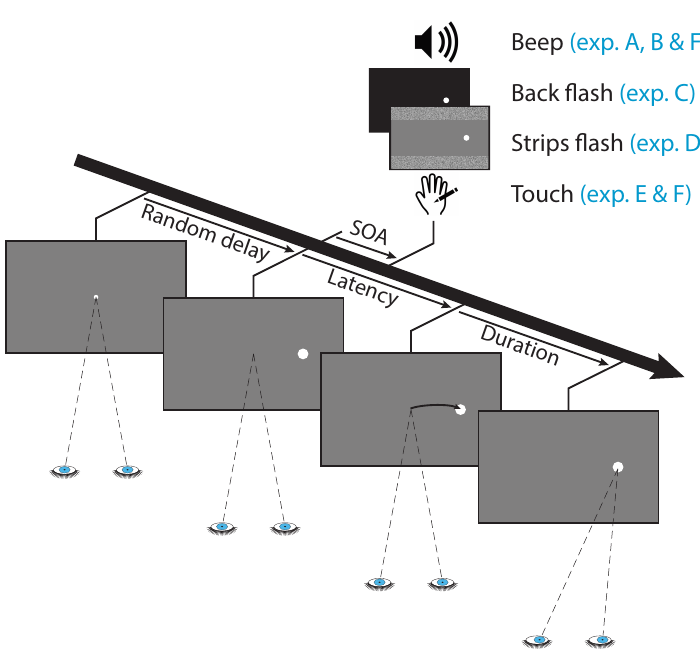
Fig 1. Time course of a trial with the different signals used for each experiment. A central fixation point is presented for a random duration (ranging from 750 to 1250 ms) then the target appears either to the left or to the right and a brief signal is delivered either before or after target onset (SOA ranging from − 240 to +240 ms). The signal was either a beep (exp. A, B & F), a background luminance decrease (exp. C), a pair of isoluminant strips (exp. D) or a tactile vibration (exp. E & F), all lasting about 10 ms. In trials with the baseline conditions, no signal was delivered. The participant had to shift gaze toward the target as fast as possible, regardless of the non-informative signal. The saccade latency is defined as the delay between the target appearance and the eye-movement onset; the saccade duration is the time needed to land on the